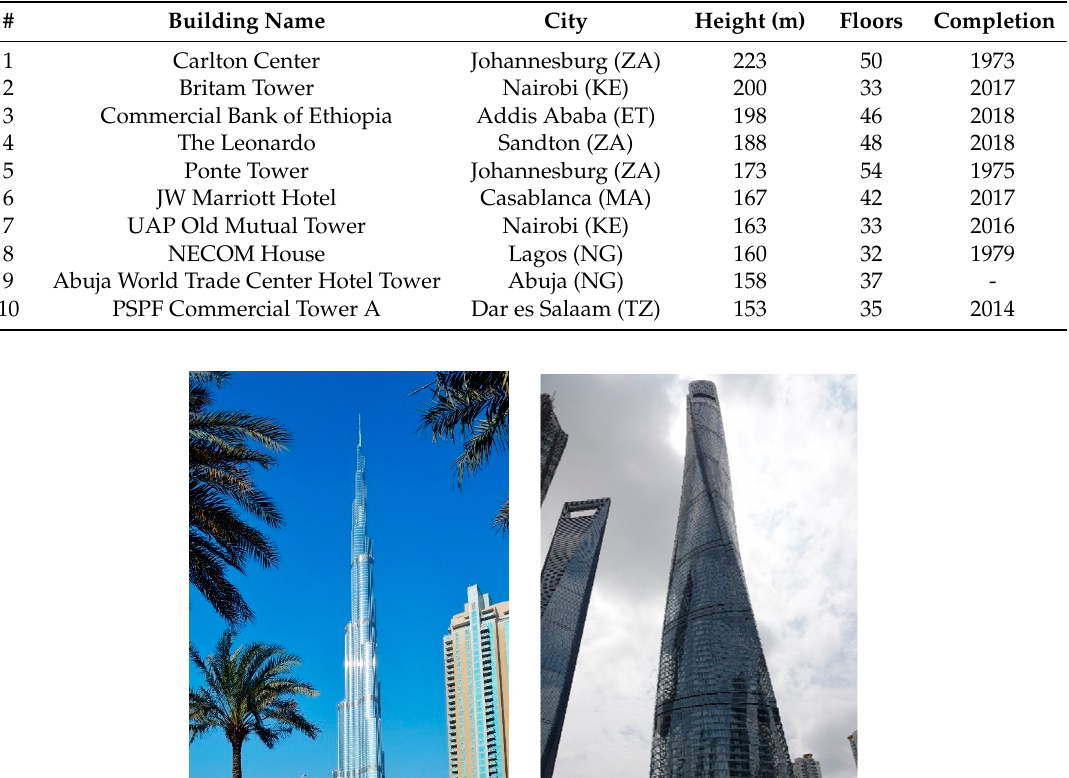
Table 12. Africa’s 10 tallest skyscrapers in 2020.